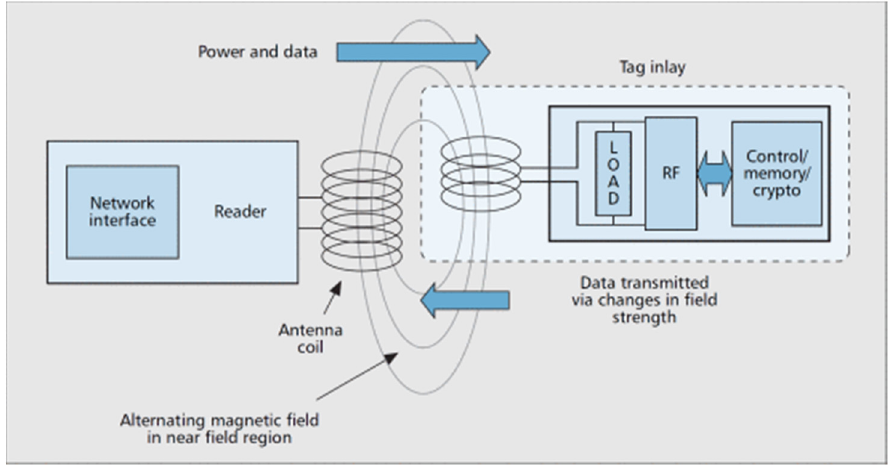
Figure 2. RFID Reader and Tag [29].